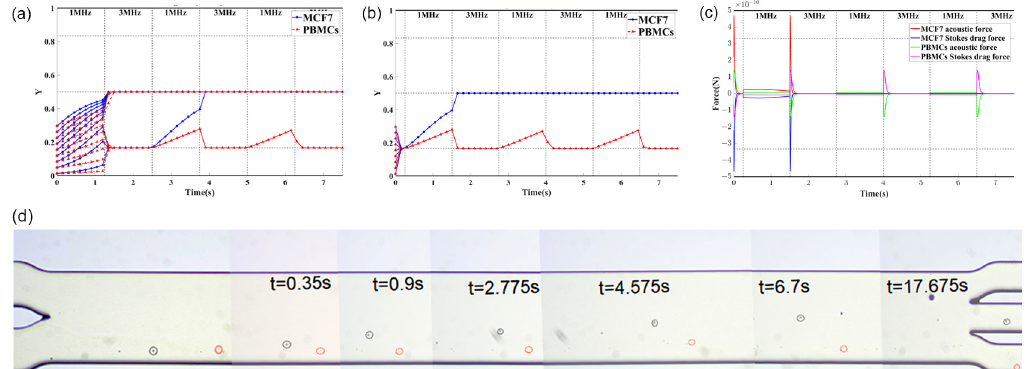
Figure 8. The simulated trajectories of the MCF7 cells and PBMCs entering the acoustic field at different times with y0 < W/3. ( a ) Cells entered the acoustic field at the beginning of the 1 MHz mode. ( b ) Cells entered the acoustic field at the end of the 3 MHz mode. ( c ) Acoustic radiation force and Stokes drag force acting on MCF7 and PBMCs corresponding to the case shown in Figure ( b ). ( d ) Representative images of the separation process of MCF7 cells (black circle) and PBMCs (red circle) in the acoustofluidic chip.